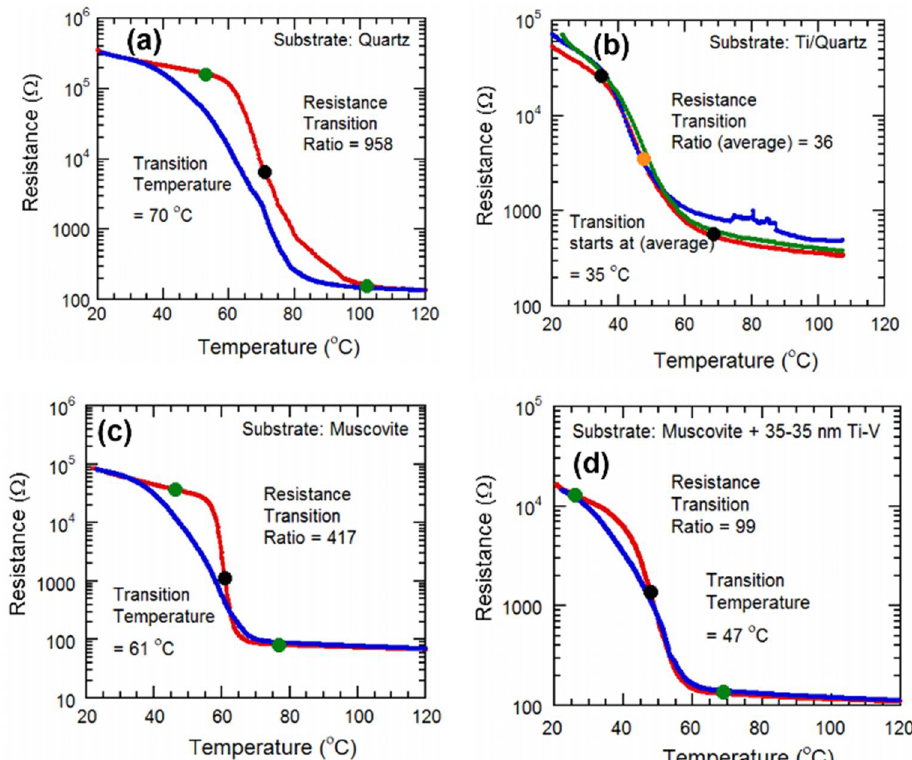
Figure 1. The phase transitioning plots of VO 2 thin films synthesized on ( a ) AT-cut quartz, ( b ) Ti (35 nm, doping layer) coated AT-cut quartz, ( c ) muscovite, and ( d ) Ti (35 nm, doping layer) coated muscovite.